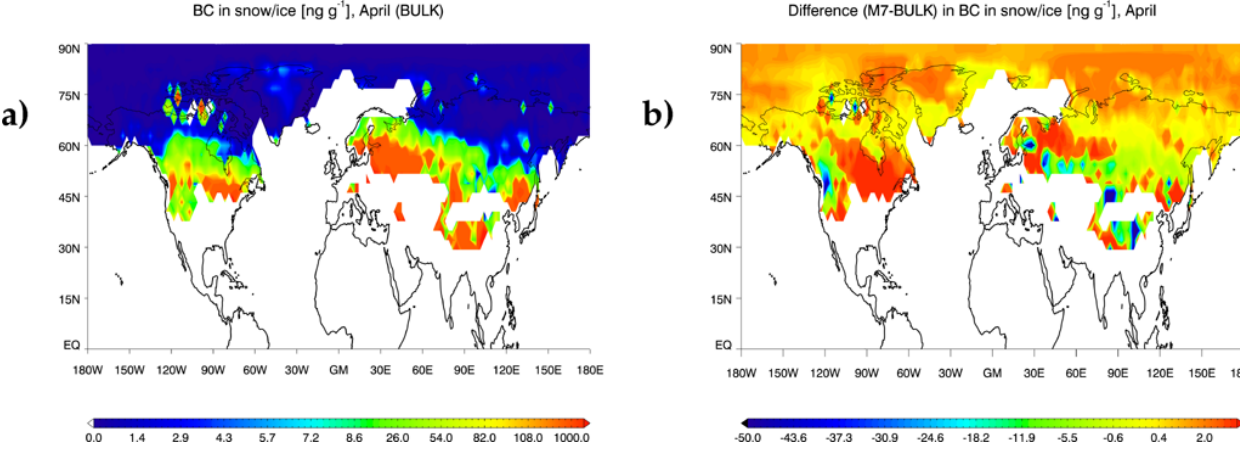
Table 1. Ratio of modelled and measured BC in snow averaged of all measurements in individual regions as given by Doherty et al. (2010). Ratio modelled/ measured BC concentration in snow Region BULK M7 Arctic Ocean 0.79 1.20 Canadian Arctic 0.86 1.07 Alaska N. slope 1.43 0.81 Canada sub-Arctic 0.15 0.15 Greenland 0.79 0.83 Svalbard 0.08 0.19 Tromsø 1.79 1.96 0.01